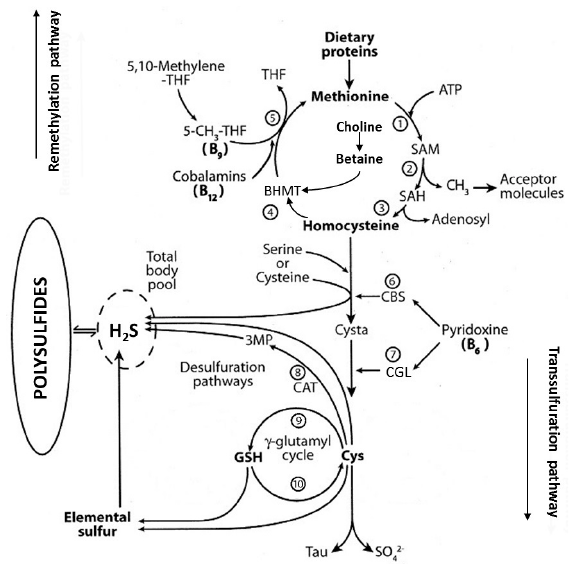
Figure 1. Main endogenous pathways of methionine metabolism. Compounds: ATP, adenosyl-triphosphate; Cys, cysteine; Cysta, cystathionine; GSH, glutathione; H 2 S, hydrogen sulfide; 3MP, 3-mercaptopyruvate; SAH, S -adenosyl-homocysteine; SAM, S -adenosyl-methionine; Tau, taurine; THF, tetrahydrofolate; SO 42- , sulfate oxyanions. Enzymes: (1) Met adenosyl-transferase; (2) SAM methyltransferase; (3) adenosyl-homocysteinase; (4) BHMT, betaine-homocysteine-methyltransferase; (5) MS; methionine-synthase; (6) CBS, cystathionine β -synthase; (7) CGL, cystathionine γ -lyase; (8) γ -glutamyl-synthase; (9) γ -glutamyl-transpeptidase (adapted from [4]).